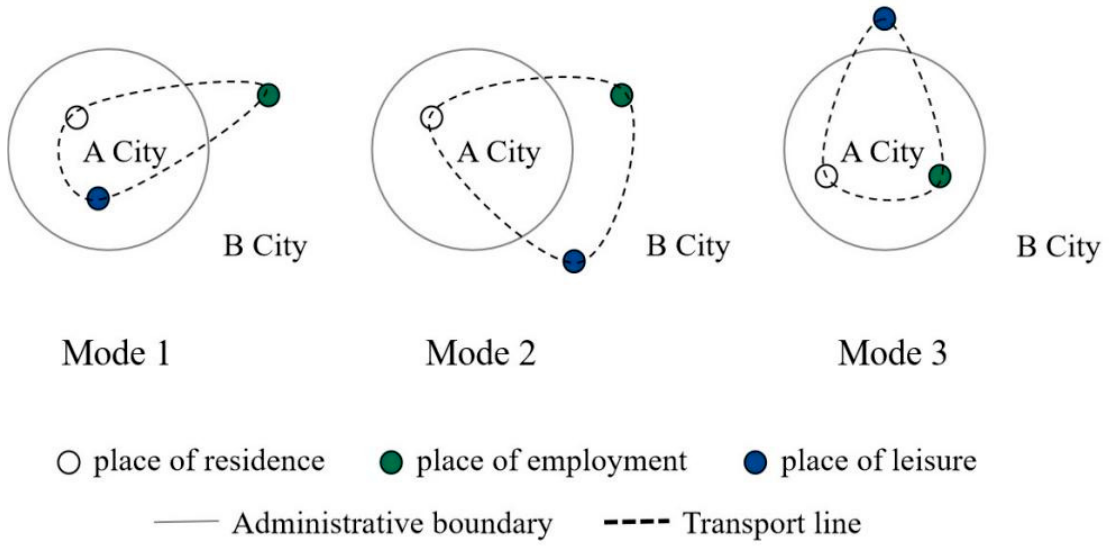
Figure 8. Cross-city travel patterns of residents in the cross-border